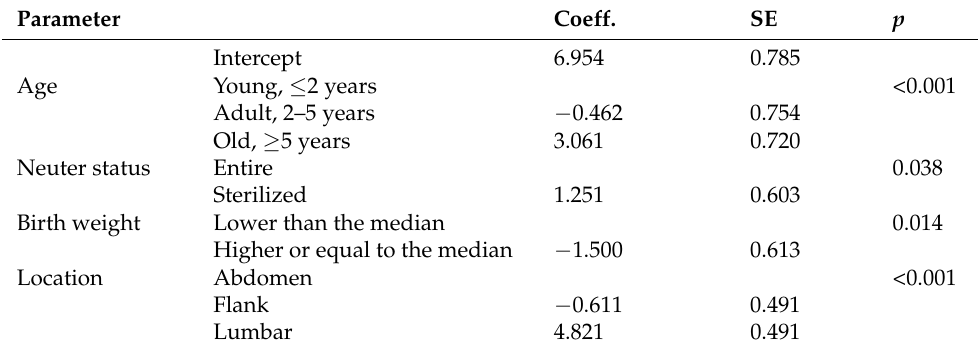
Table 2. Linear mixed regression model analysis for subcutaneous fat thickness ( n = 88